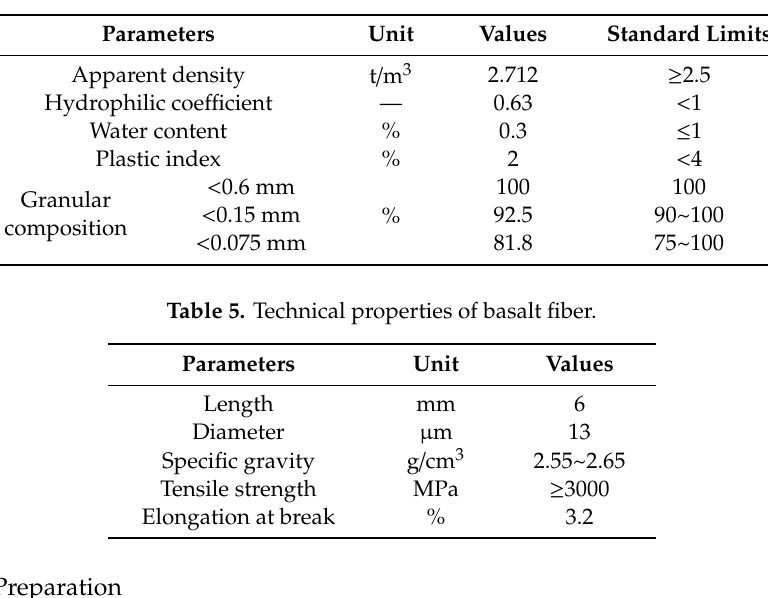
Table 4. Technical properties of mineral filler.